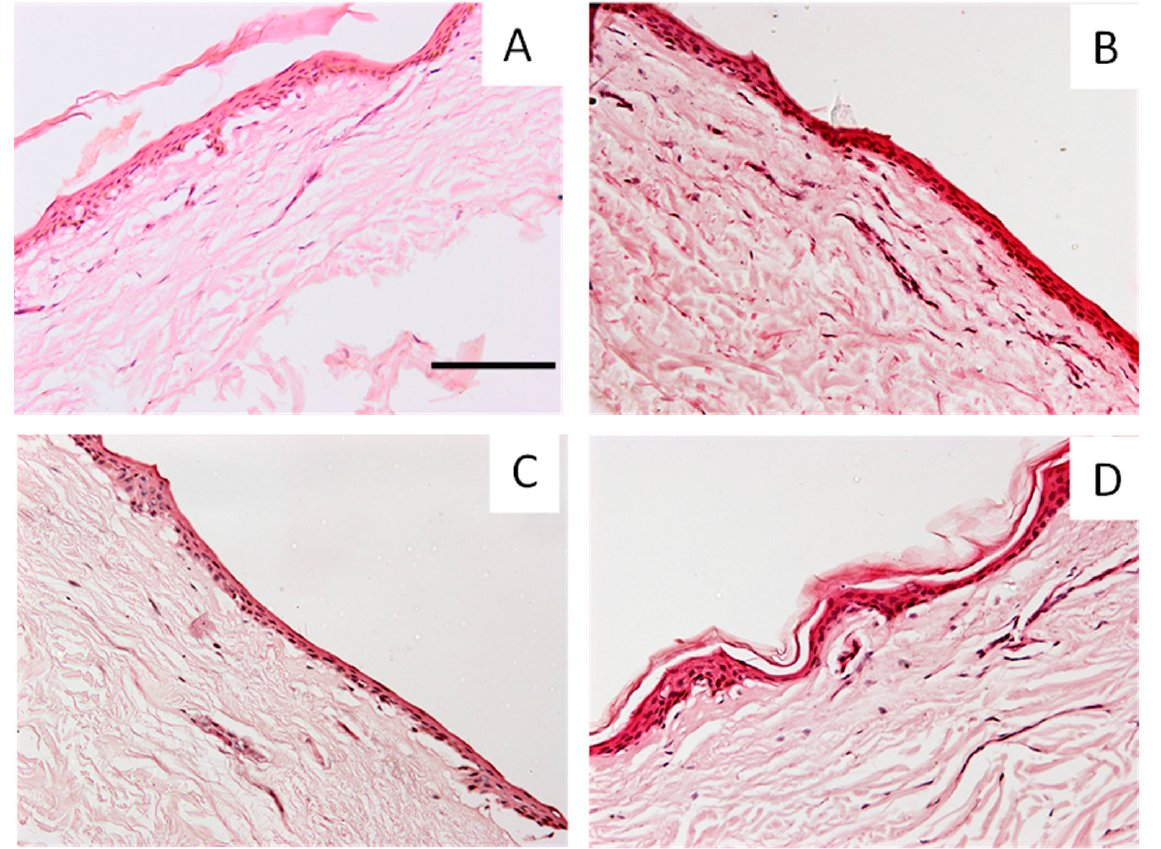
Figure 9. Representative histological sections of human skin stained with haematoxylin and eosin in ( A ) blank conditions (ethanol) and after being in contact with a saturated ethanolic solution of ( B ) CAT, ( C ) CUR or ( D ) BDMC . Scale bar = 100 µm.